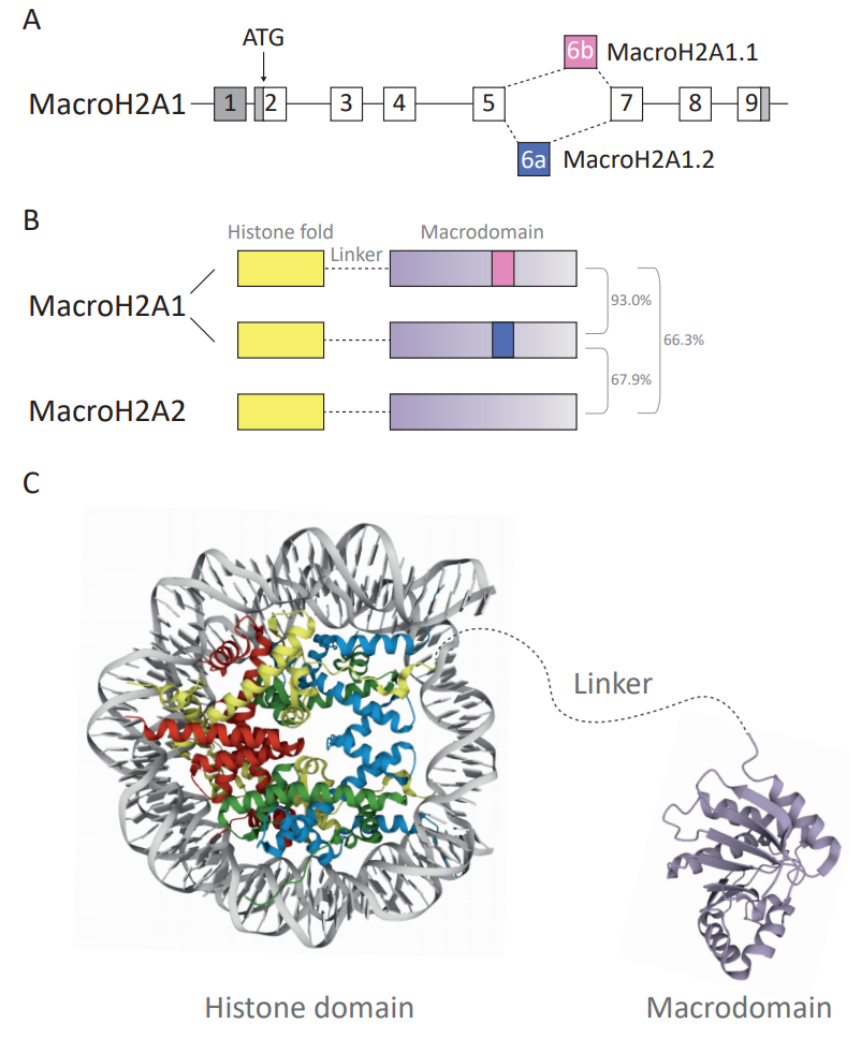
Figure 2. ( A ) Diagram depicting the structure and splicing of the gene encoding macroH2A1 (H2AFY). Gray boxes represent non-coding exons, white boxes represent coding exons. The macroH2A1.1- and macroH2A1.2-specific exons are in pink and blue, respectively. ( B ) Schematic of the three human macroH2A variants’ domain architecture. Total amino acid sequence identity is shown as a percentage. ( C ) Crystallographic structure representation of the macroH2A-containing nucleosome and macrodomains. The protein structure of the unstructured basic linker region depicted in gray is not known. The nucleosome and macrodomain are colored by molecule type. DNA—gray, H2A—yellow, H2B—red, H3—blue, H4—green, macrodomain—purple. The protein structure was generated with protein data bank [70,71] ID: histone fold domain (3REH) [72] and macrodomain of macroH2A1.1 (1YD9) [28].